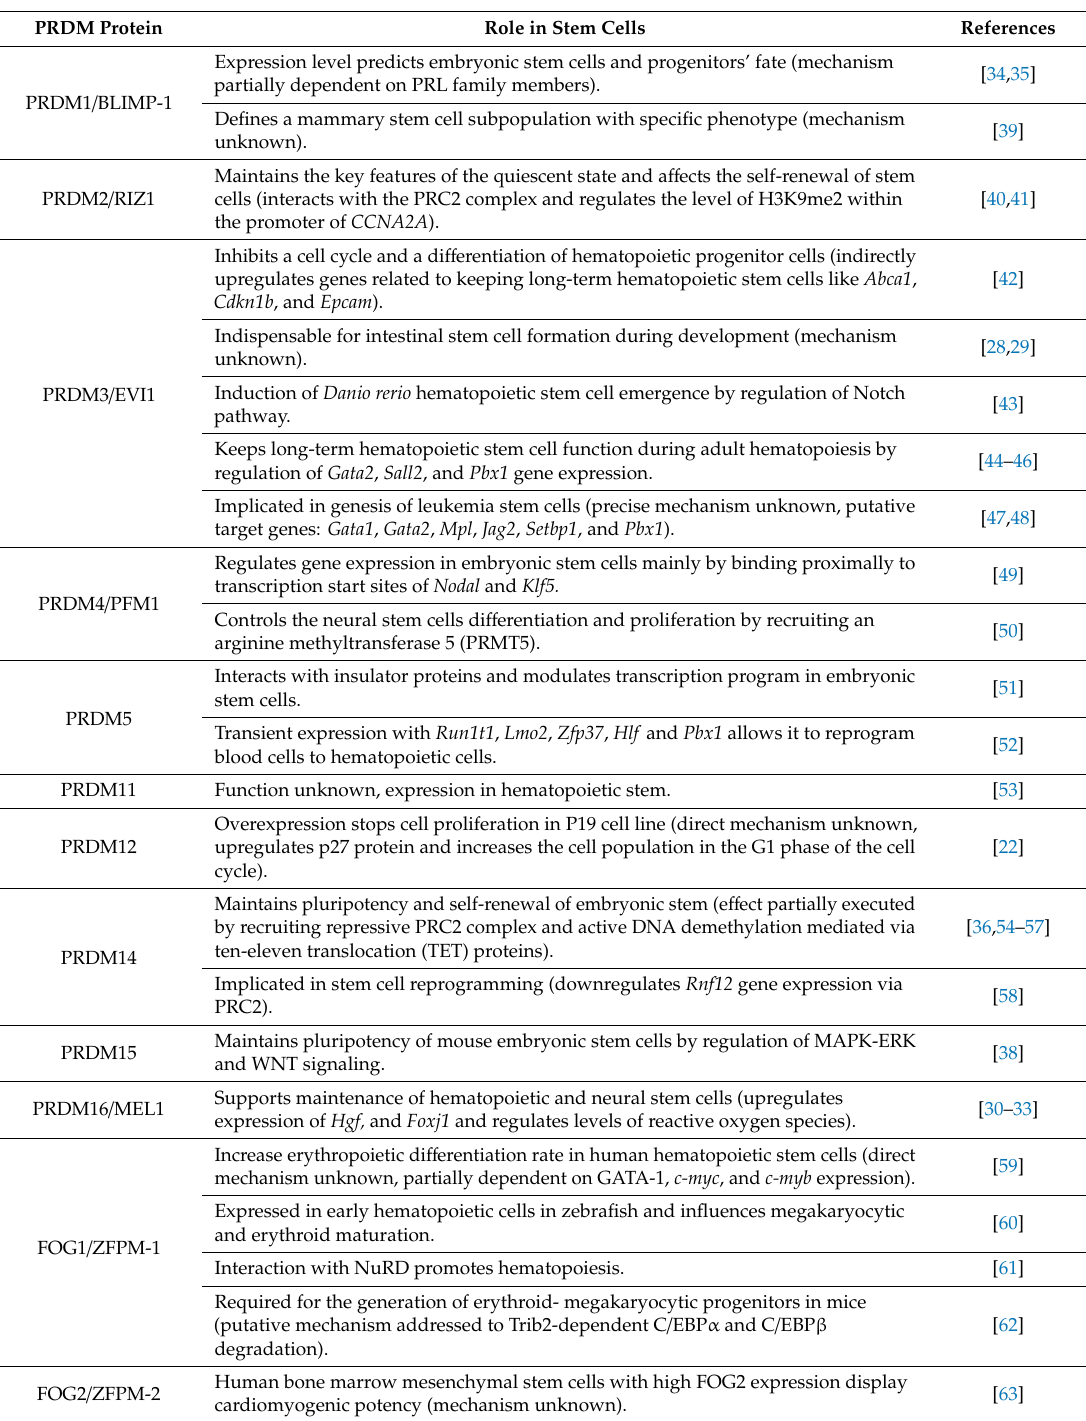
Table 1. Roles of PRDM factors in stem cell